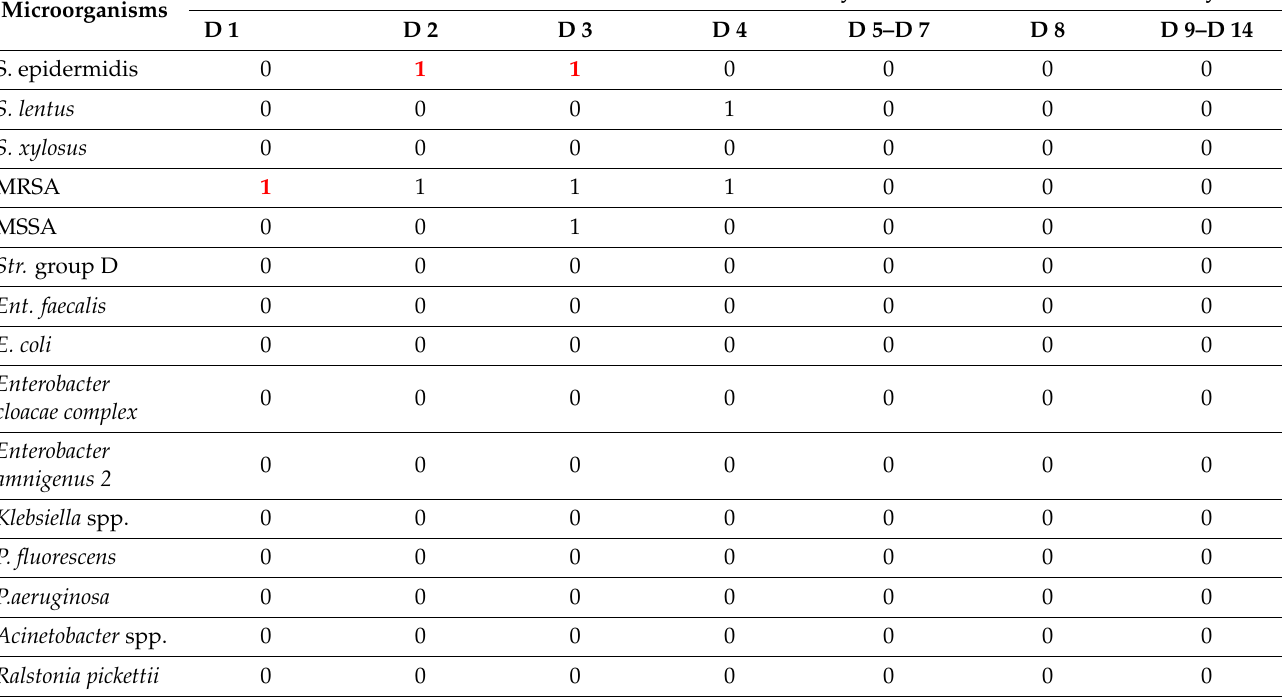
Table 3. Isolated bacterial species (no. of strains identified) from synovial fluid/incubation period days.